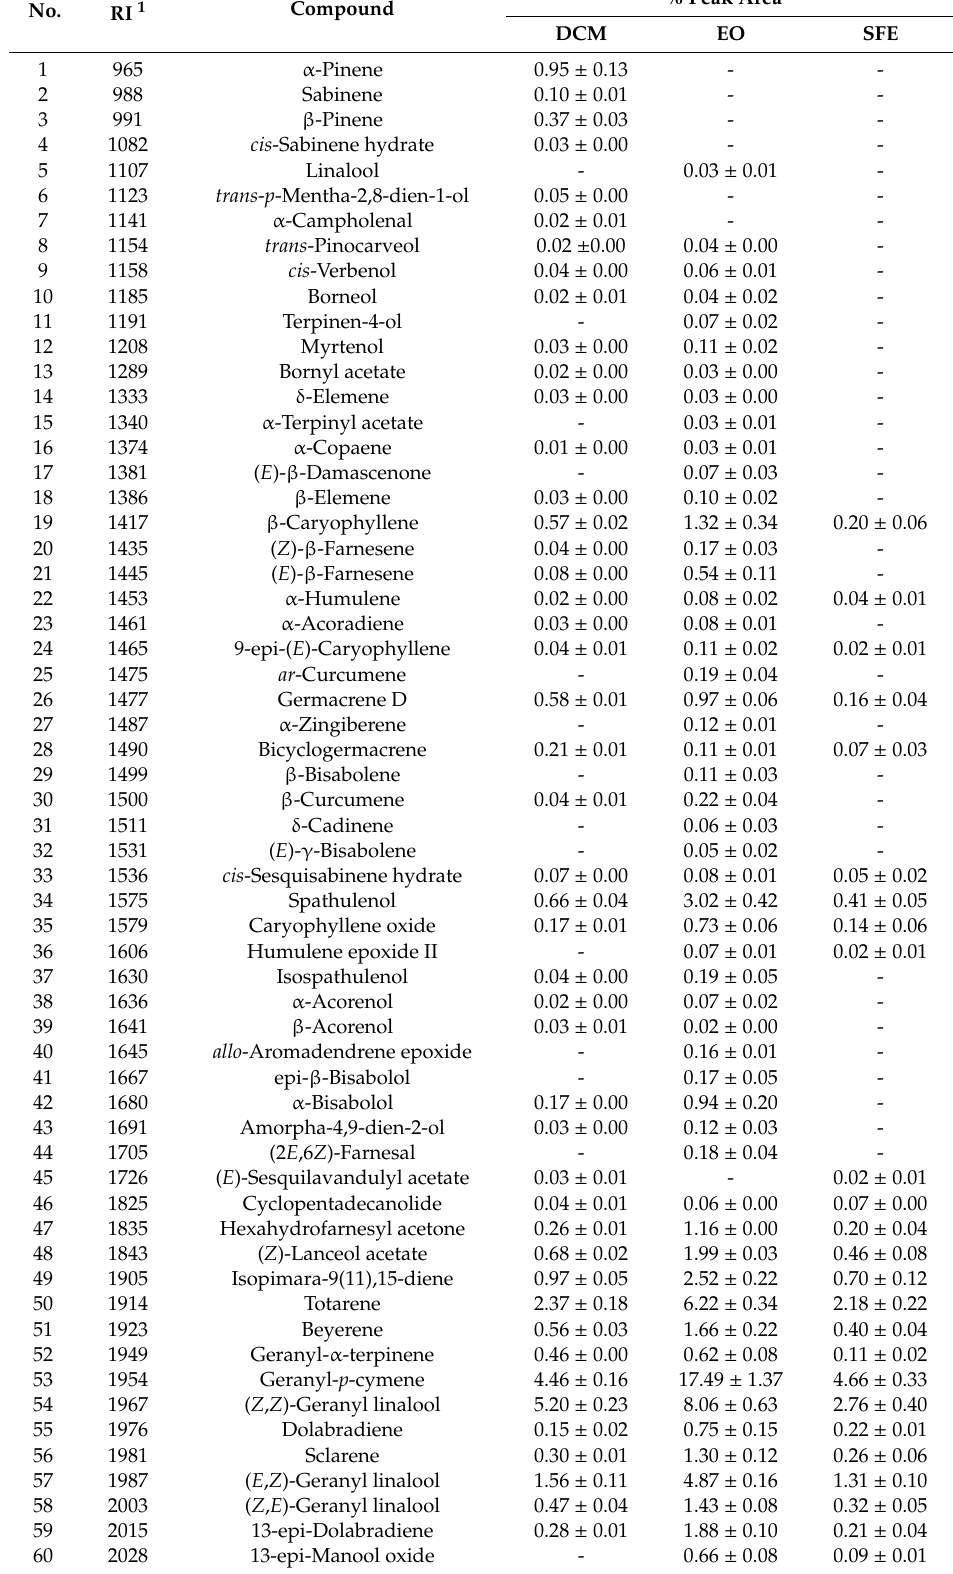
Table 2. GC-MS analysis of S. sipylea non-polar extracts obtained using ultrasound-assisted extraction with dichloromethane (DCM), supercritical fluid extraction (SFE), and hydrodistillation